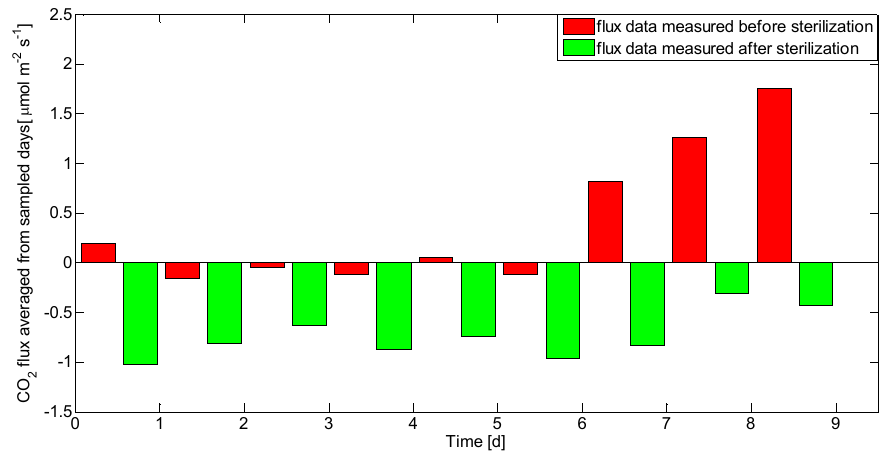
Figure 1. Contrast of mean CO 2 flux before/after sterilization.